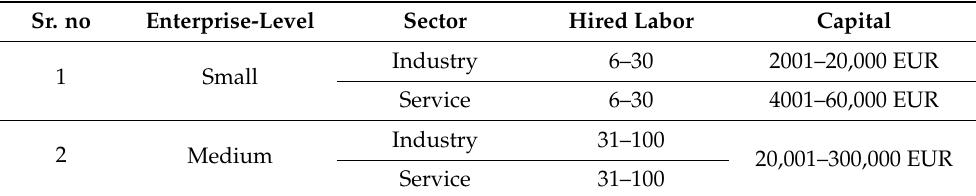
Table 1. SME classification in